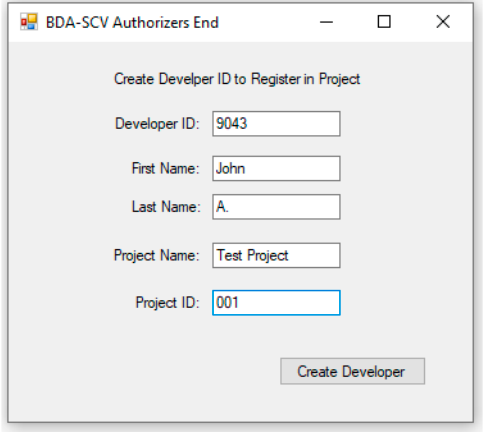
Figure 13. BDA-SCV authorizer’s end view.